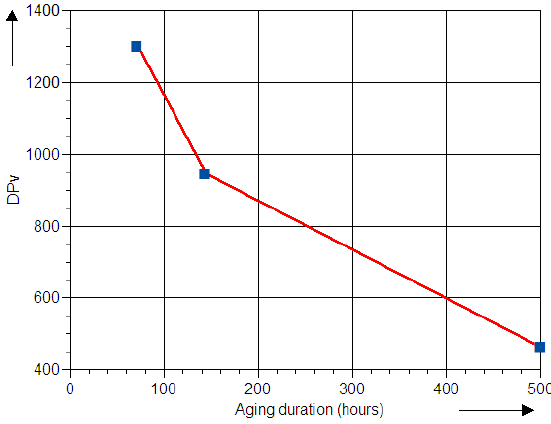
Figure 8. Evolution of the degree of polymerisation as a function of thermal ageing.